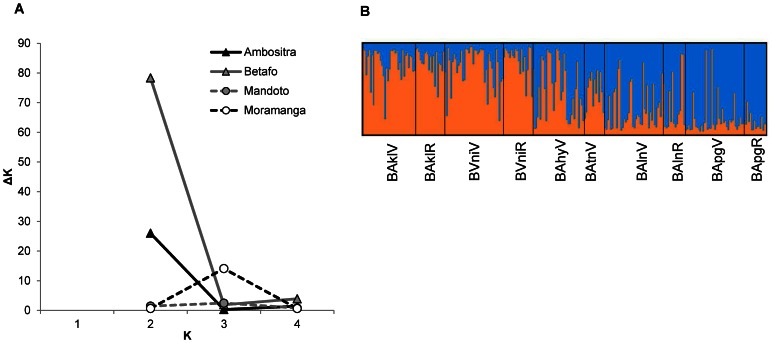
Results of Structure analyses.(A) Estimates of ΔK for each possible value of K within each of the four areas; (B) Structure bar plot for the run with the highest estimated posterior probability for Betafo at K = 2: subpopulations are ordered from south (left) to north (right).